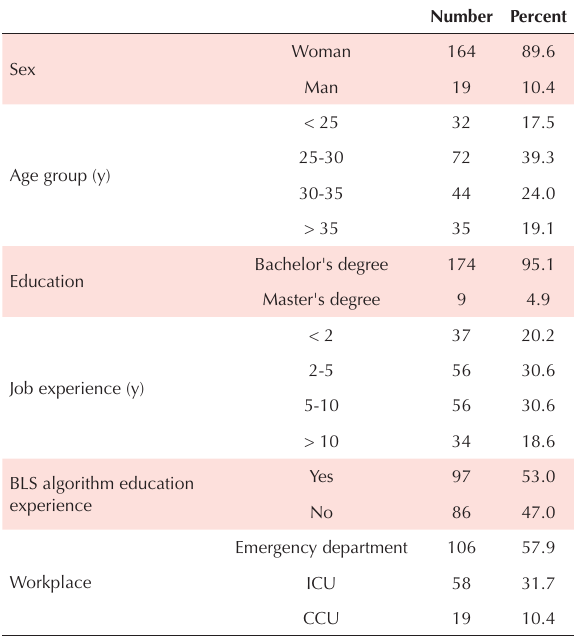
Table 1. Demographic Characteristics of the Studied